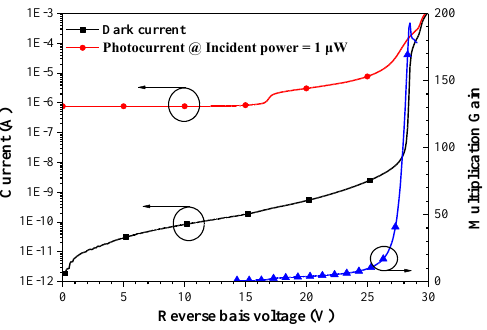
Figure 3. Dark current, photocurrent, and multiplication gain of conventional APD diodes as a function of reverse bias voltage.